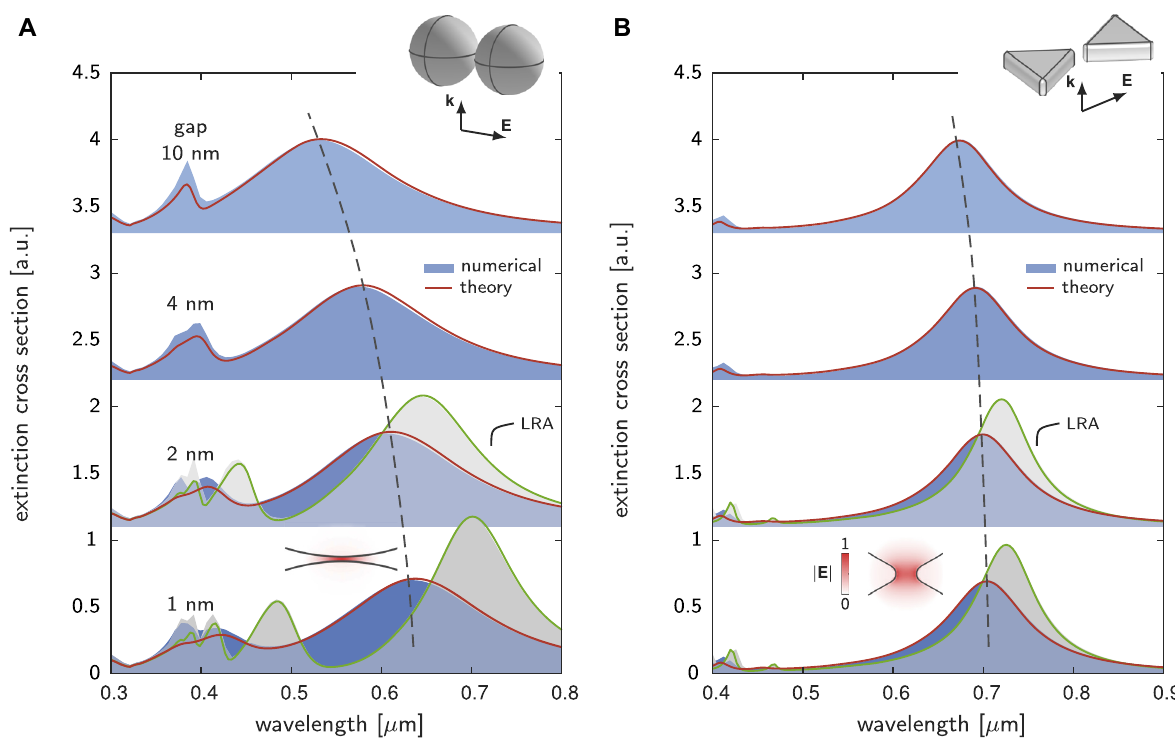
Figure 3: Modal analysis of extinction cross-section spectra for spherical dimers (A) and bow-tie structures (B), incorporating both retardation and nonclassical effects. The nanoparticles, made of Ag, are embedded in a dielectric medium with refractive index of 1.33. The gap varies from 10 nm (top) to 1 nm (bottom). The spheres in (A) have a diameter of 80 nm, while the triangles in (B) have a side length of 100 nm and a height of 25 nm. The results predicted by the modal method agree well with the numerical solutions obtained with COMSOL Multiphysics. In the modal method, four modes in both (A) and (B) are used, and the modal coefficients are obtained by solving Eq. (4). The retardation series in Eq. (6a) is truncated to the power k = 5. As the gap narrows progressively, plasmon hybridizations become stronger, which renders the resonances a redshift (visualized by dashed lines). To illustrate the effects of the nonclassical effects at small gap sizes, we include the extinction cross-section spectra under the local-response approximation (LRA) by setting d ⊥ = 0. The insets sketch scattering of the dimer structures by plane waves and profiles of the lowest-order bounding dipolar